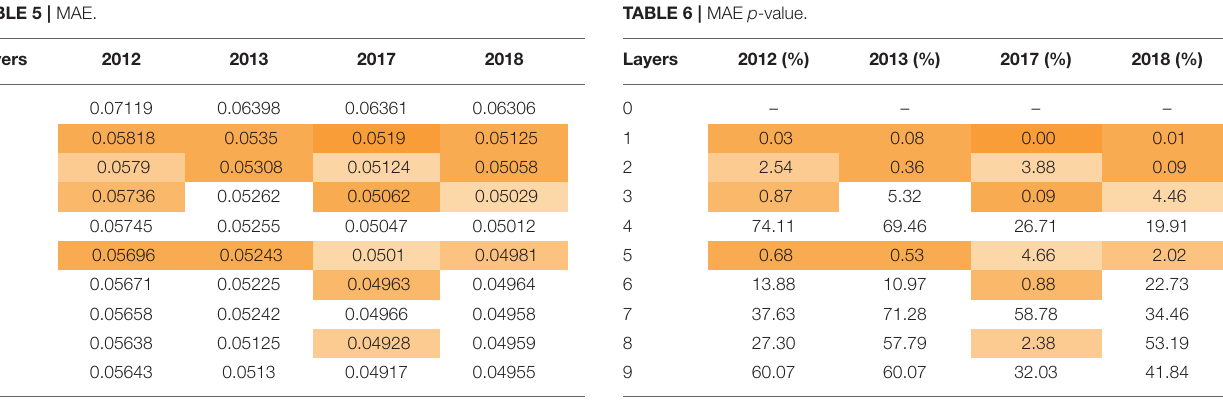
Darker shades represent lower p-values, e.g. a stronger statistical